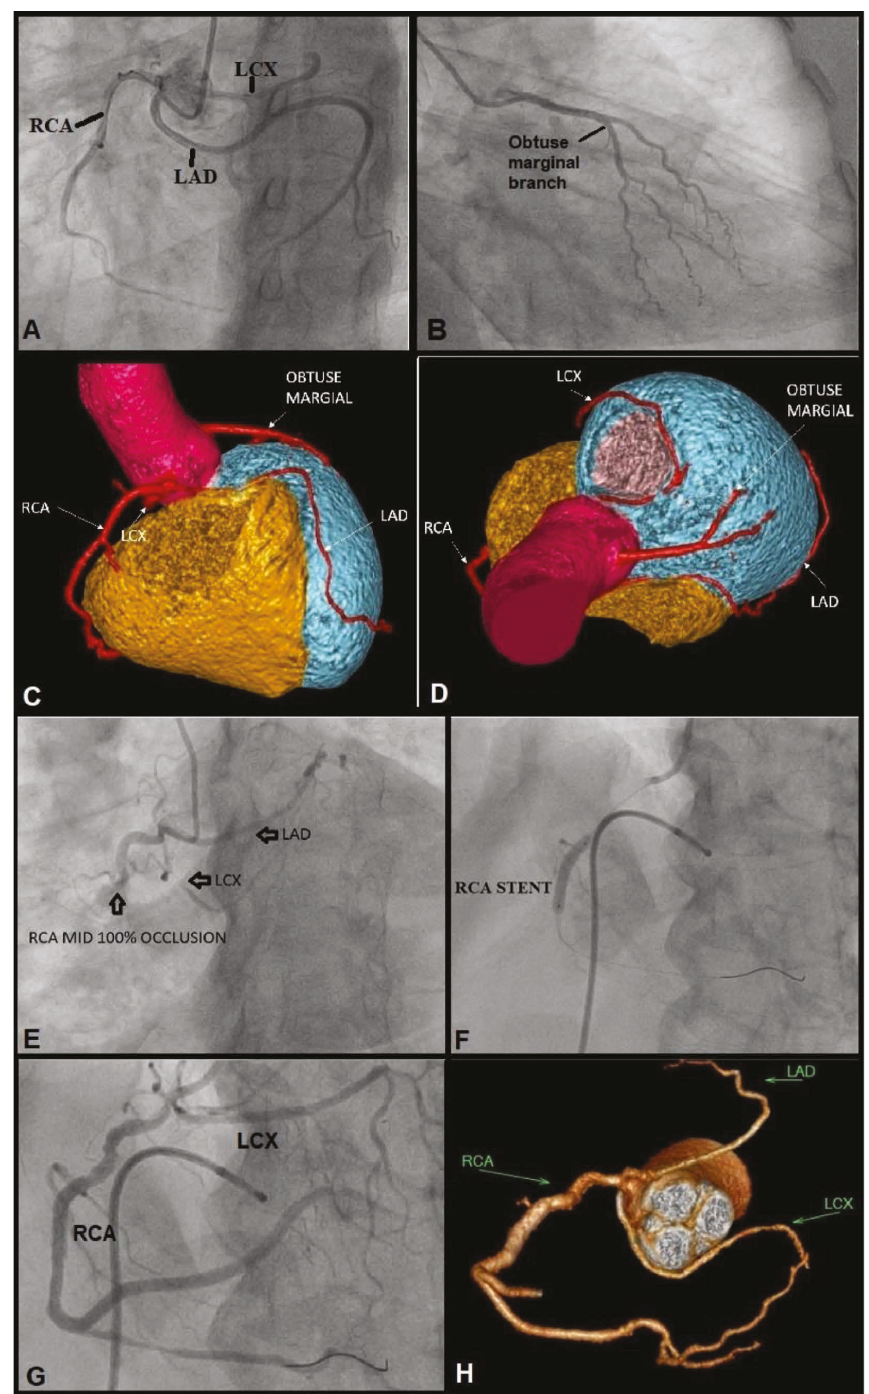
Figure 1: (a): Coronary angiogram showing the origin of all 3 major coronaries from the right coronary sinus via common ostium. (Case 1). (b): CAG showing a branch arising from the left sinus supplying obtuse marginal territory. (Case 1). (c) & (d): 3D volume- rendered reconstructed CT image showing the origin of LAD, LCX, and RCA from the right sinus of Valsalva via common ostium and origin of the small obtuse marginal branch from the left sinus of Valsalva. (Case 1). (e): CAG showing the origin of all 3 major coronaries from the right sinus along with complete occlusion of RCA and 90% occlusion of LCX. (Case 2). (f): Image showing the stent in RCA along with temporary pacemaker lead in the right ventricle. (Case 2). (g): Post angioplasty image showing TIMI-III flow in RCA and LCX. (Case 2). (h): Volume-rendered coronary tree showing the common origin of all 3 major coronaries from the right sinus. (Case